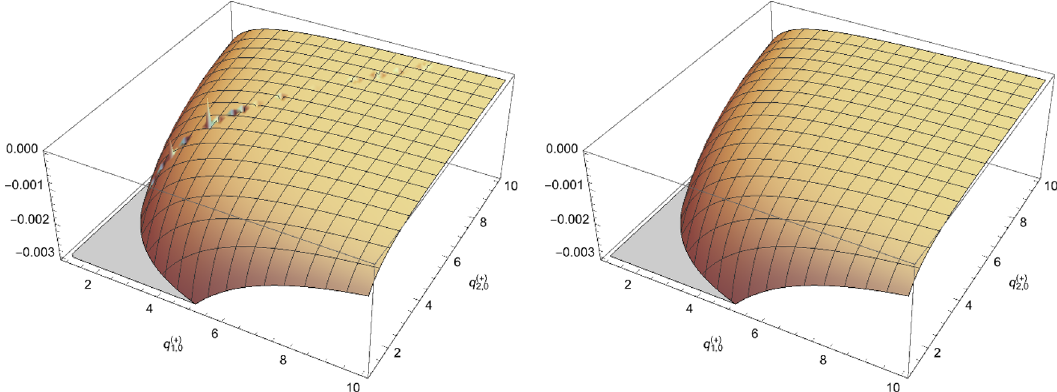
Figure 2 . Three dimensional plots for the integrand of the two-loop sunrise diagram in terms of non-causal (left) and causal (right) propagators. The numerical fluctuations due to numerical cancellations of non-causal thresholds are visible on the left plot. The right plot is stable because the integrand expression is manifestly free of non-causal